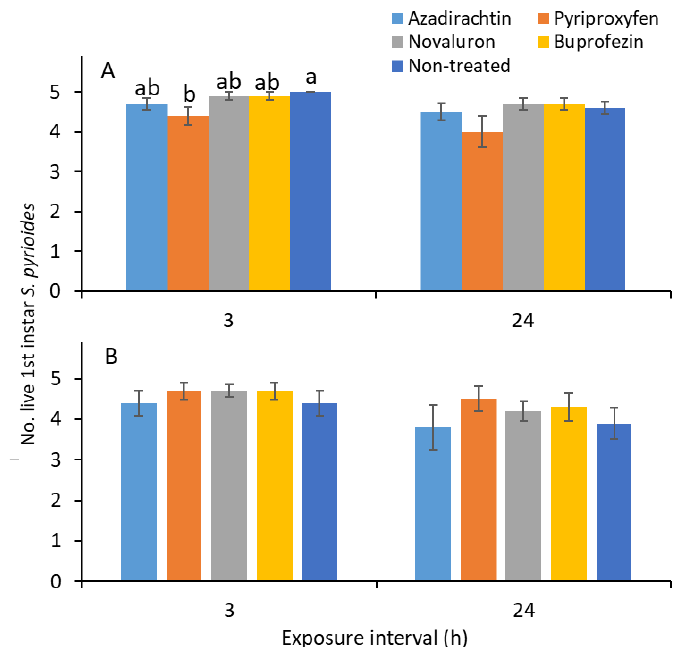
Figure 5. Mean (±SE) numbers of first S. pyrioides instars that survived after 3 and 24 h of exposure to aged IGR residues for ( A ) 1 and ( B ) 7 d after spray application. Bars with the same letters within the exposure time are not significantly different at α = 0.05 (Tukey’s HSD test). Nonsignificant data have no letters.